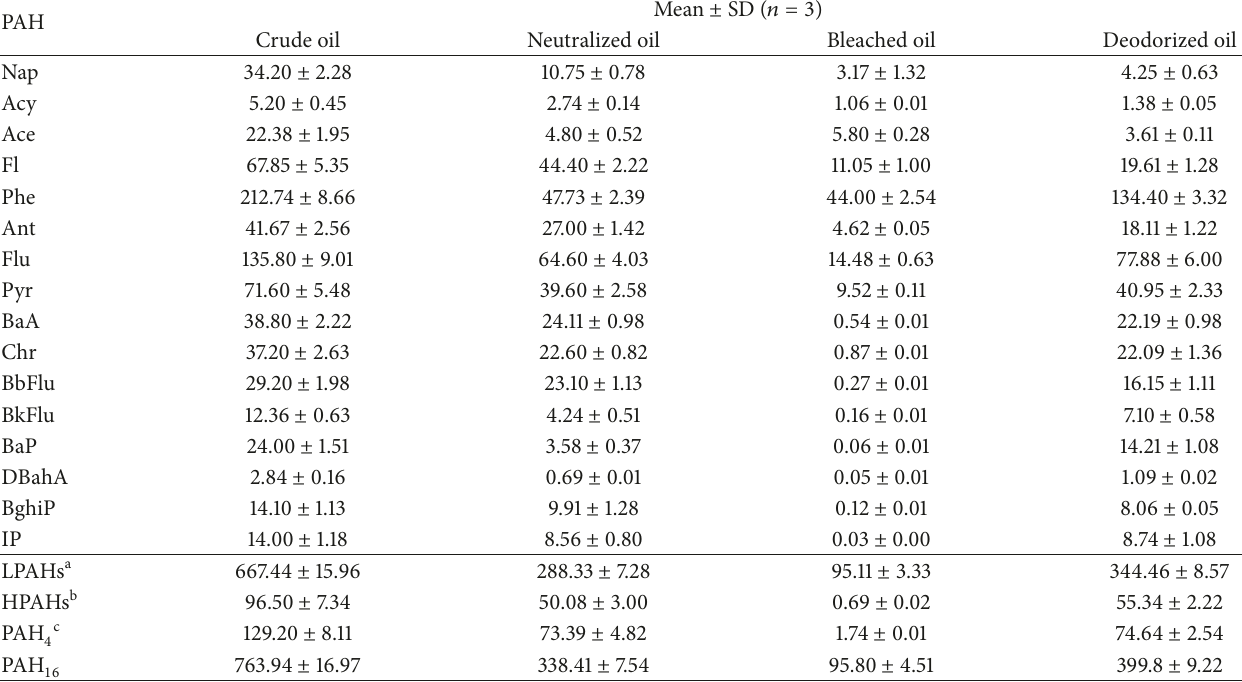
Table 4: PAHs content (mean ± SD ( 𝑛 = 3 )) in crude oil and each step of the oil refining process.